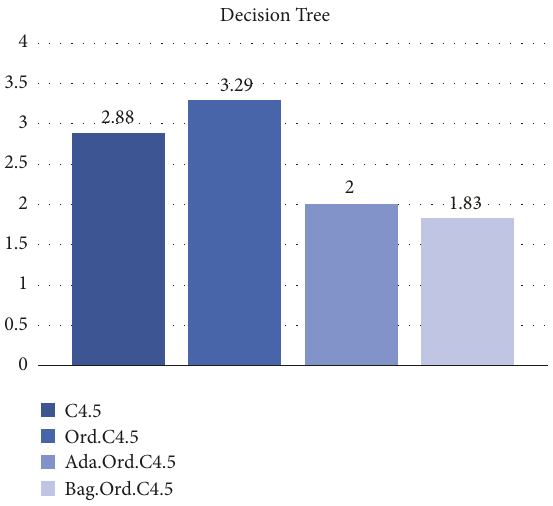
Figure 5: The average ranks of C4.5 algorithm with ordinal and ensemble-learning versions.